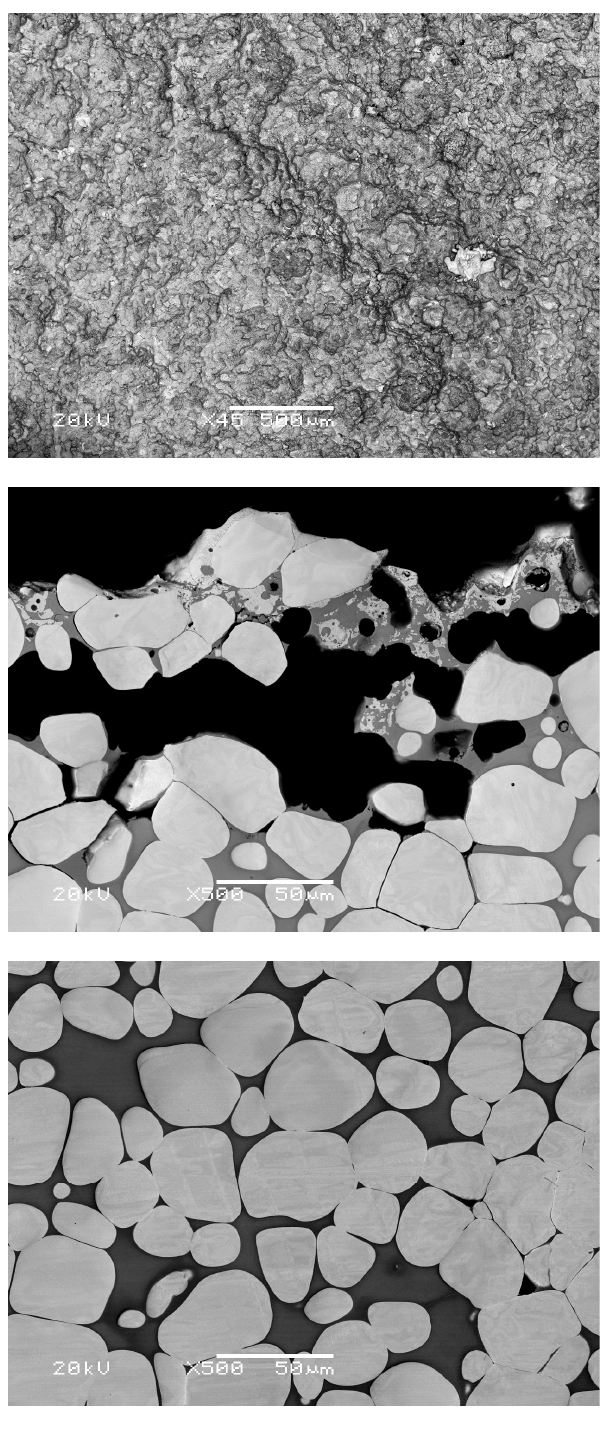
material.FIG. 5. Backscattered electron micrograph for HD-17. The top picture is a surface picture of an arc region. The middle picture is a cross section of an arced region. The bottom picture is a cross section of the bulk